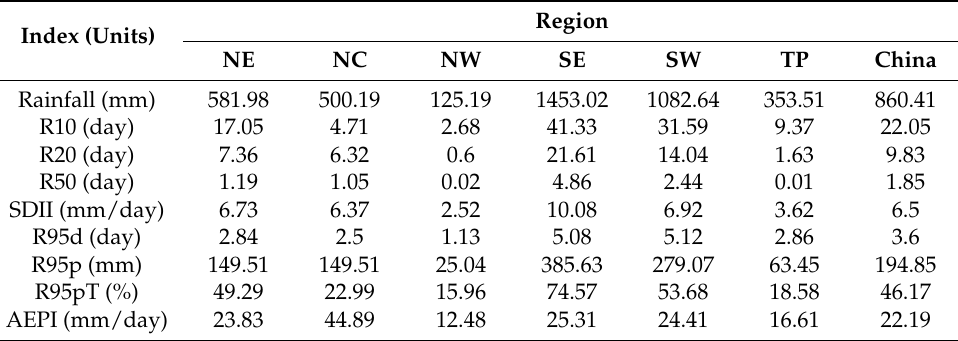
Table 3. Averages of extreme precipitation indices in six regions in